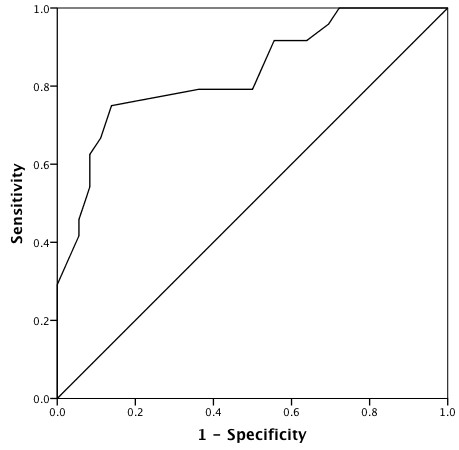
Receiver-operating characteristic (ROC) curve for predicting 90-day mortality by using the peak systolic velocity measured at the mitral annulus (Sa). Area under the curve is 0.83.